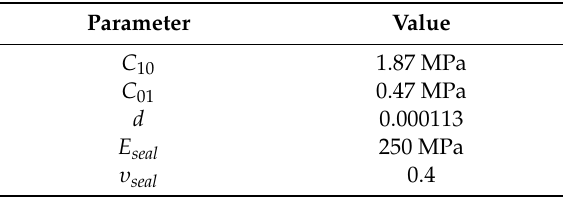
Table 1. Parameters of the step